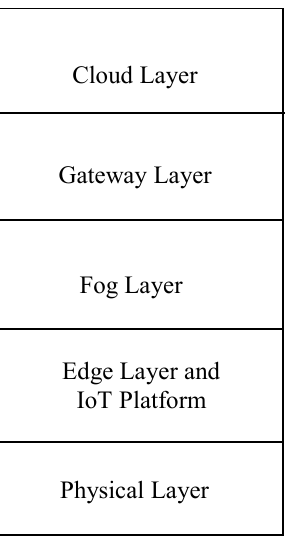
Fig. 1. IoT data communication model. Edge-Fog-Cloud communication stack that defines the five stages of message passing and coordination. The Gateway is buffer between fog servers and cloud.